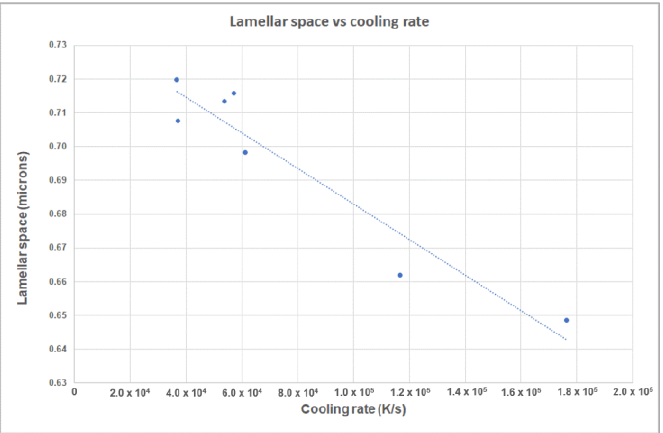
Figure 16. Lamellar spacing vs. Cooling rate.